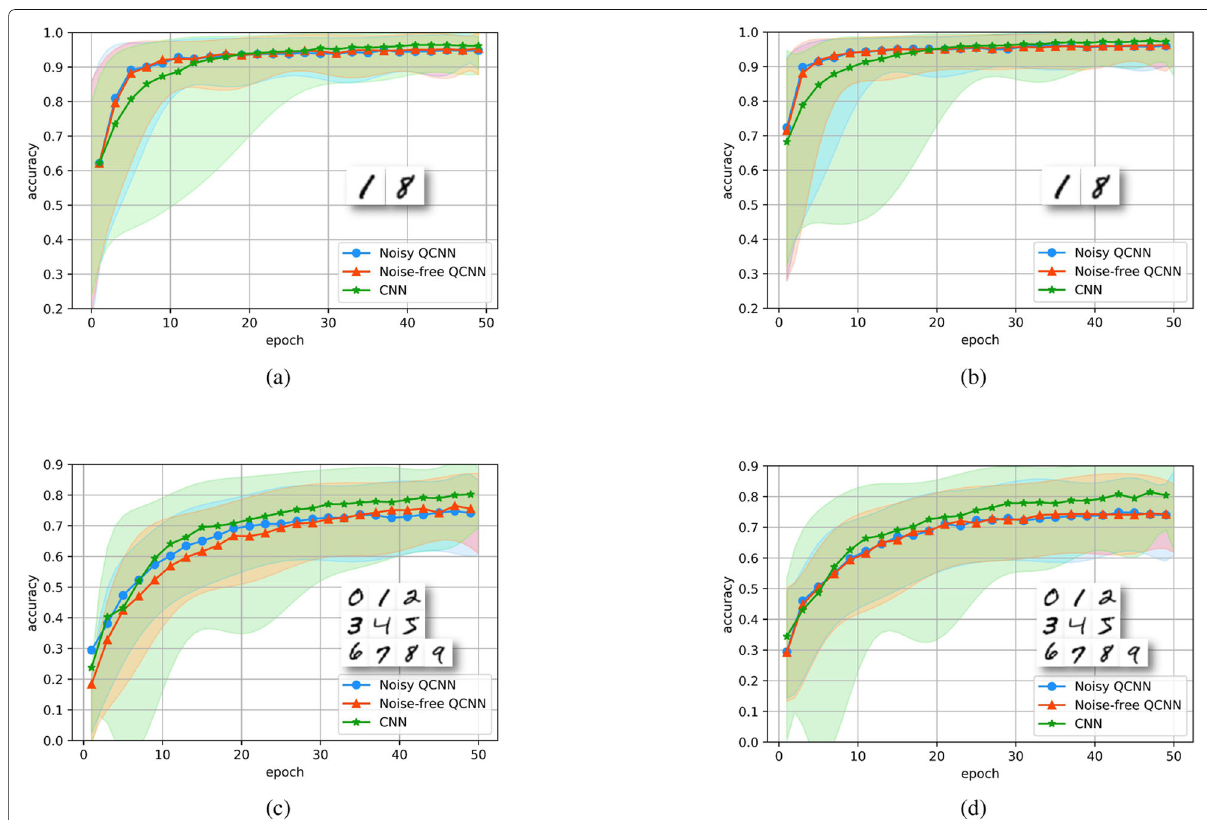
Fig. 4 The performance of QCNN based on MNIST. The blue, red, and green curves denote the average accuracy of the noisy QCNN, noise-free QCNN, and CNN, respectively. The shadow areas of the corresponding color denote the accuracy fluctuation range in the 100 times simulation results. The insets are the typical images from MNIST set. a , b The curves representing the result from the training set and the test set for the 2 class classification problem respectively. c , d The result from the training set and the test set for the 10 class classification problem respectively (cid:20) (cid:19) M 2 implementing a classical convolutional layer is O